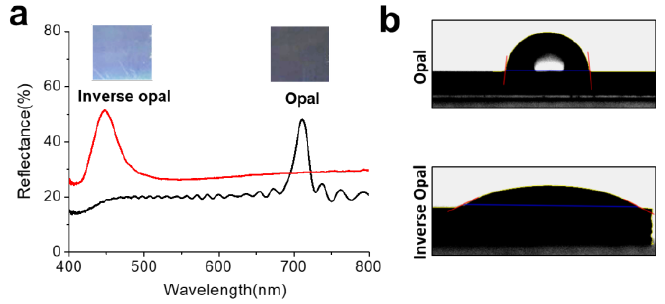
Figure 2. ( a ) Reflectance spectra of the opal and IO nanostructures. Insets are the corresponding optical microscope images; ( b ) Optical images showing contact angles of a water drop on the opal (top panel) and IO (bottom panel) nanostructures.